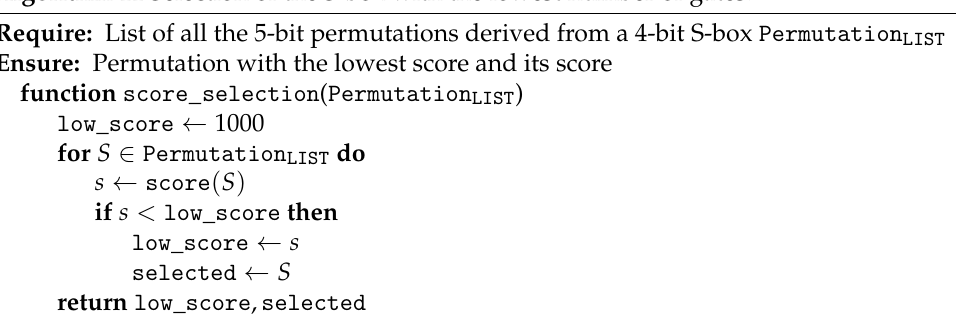
Algorithm 11 Selection of the S-box with the lowest number of gates.